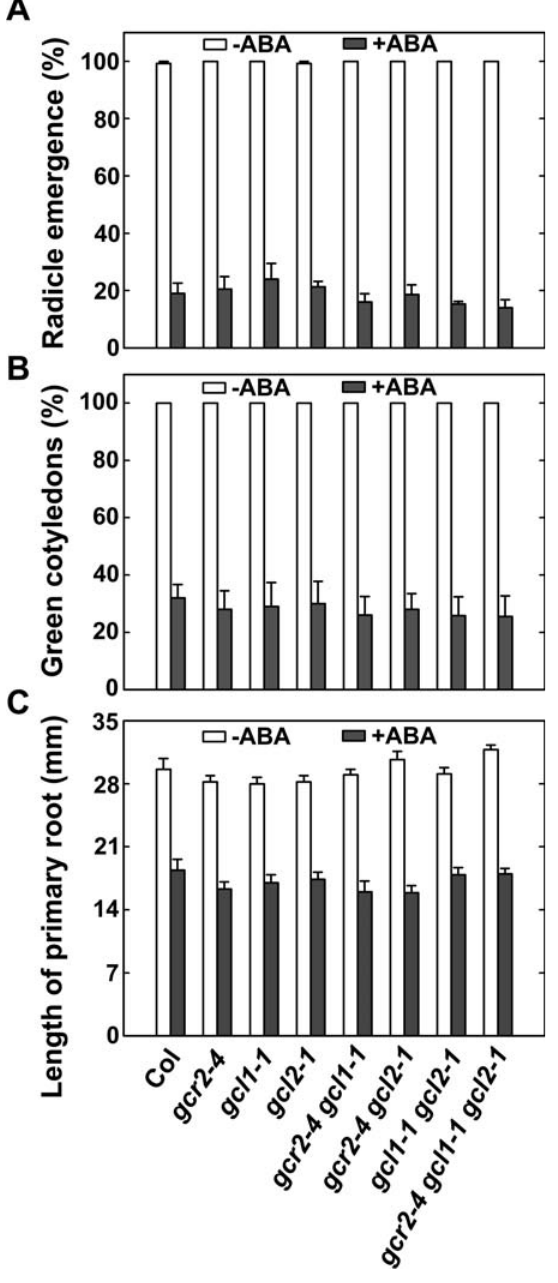
Figure 4. Sensitivities of gcr2 , gcl1 and gcl2 single, double and triple mutants to ABA in seed germination and early seedling development. ( A ) ABA sensitivity of gcr2 , gcl1 and gcl2 single, double and triple mutants in seed germination assay. ABA was used at 1.0 m M. The percentage of seeds with emerged radicles was scored 60 hr after the imbibed seeds were transferred to germination conditions. Shown are the averages of three replicates 6 S.E. ( B ) ABA sensitivity of gcr2 , gcl1 and gcl2 single, double and triple mutants in the green seedling assay. ABA was used at 1.0 m M. The percentage of seedlings with green cotyledons was scored 11 d after the imbibed seeds were transferred to germination conditions. Shown are the averages of three replicates 6 S.E. ( C ) ABA sensitivity of gcr2 , gcl1 and gcl2 single, double and triple mutants in the primary root elongation inhibition assay. ABA was used at 2.0 m M. Four- eight hours after the imbibed seeds were transferred to germination conditions, germinated seeds with emerged radicles were then trans- ferred to medium with or without ABA. The length of primary root was measured 5 d later. Shown are the averages of at least 10 seedlings 6 S.E.